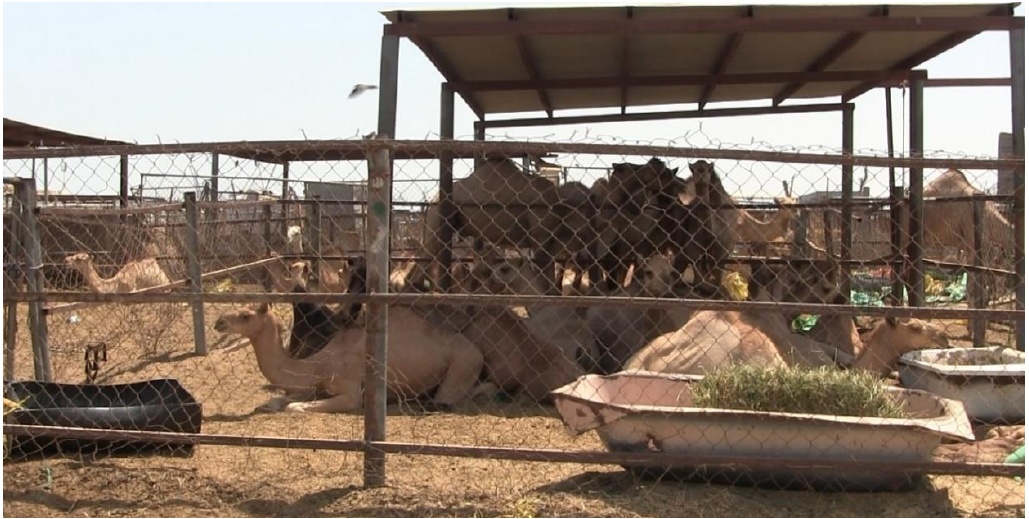
Figure 3. Frames of videos recorded at Doha market with dromedary camels crowded under the shelter, only one animal is resting with almost all its body in the sun because the shade is not available.